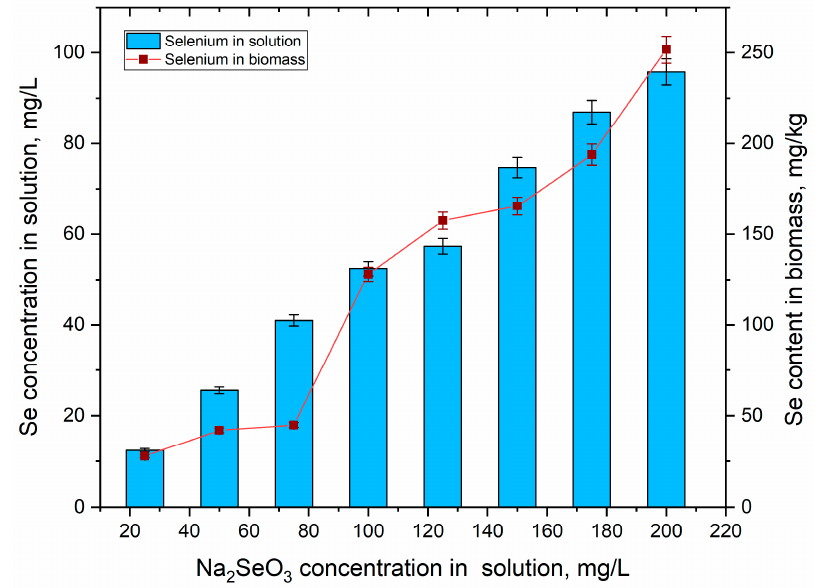
Figure 1. Selenium accumulation in Arthrospira platensis biomass (n = 3, the error bars represent the standard deviation of the measurements).